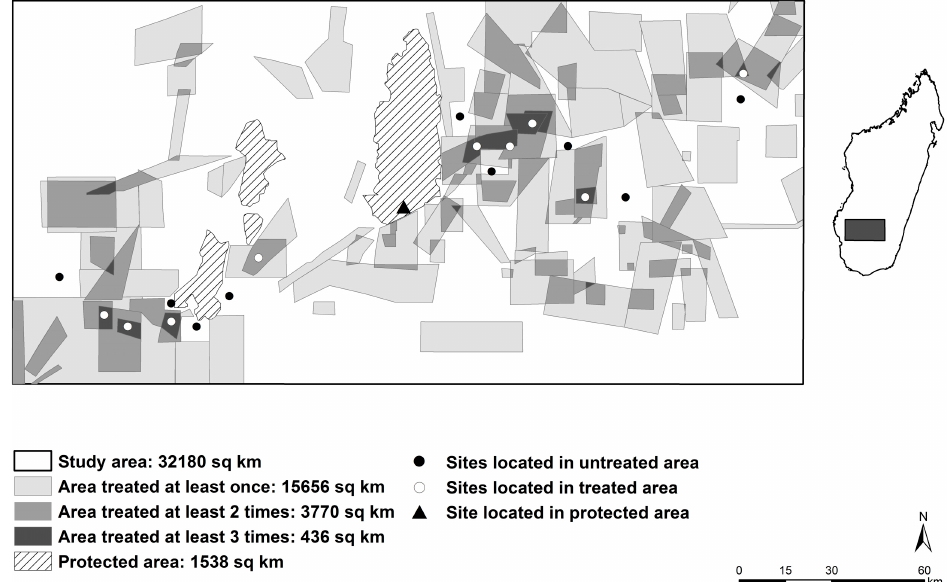
Figure 1. Study area and barrier treatment areas (targets) in southwestern Madagascar. Areas sprayed at least three times (dark grey) are included in areas sprayed at least twice (grey) and the latter are included in areas sprayed at least once (light grey). The design included 9 randomly selected pairs of sites—or blocks—located in untreated areas (black circles) and repeatedly treated hotspots (white circles), respectively. At each site, the densities, occupancies, and morphologies of termitaria were measured. At the single site located in Isalo national park (black triangle), only mound morphologies were